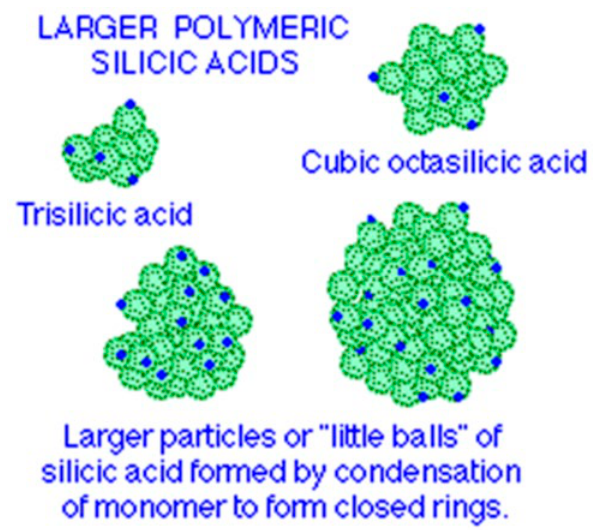
“little balls”. (A) is trisilicic acid, (B) is cubic octasilicic acid that